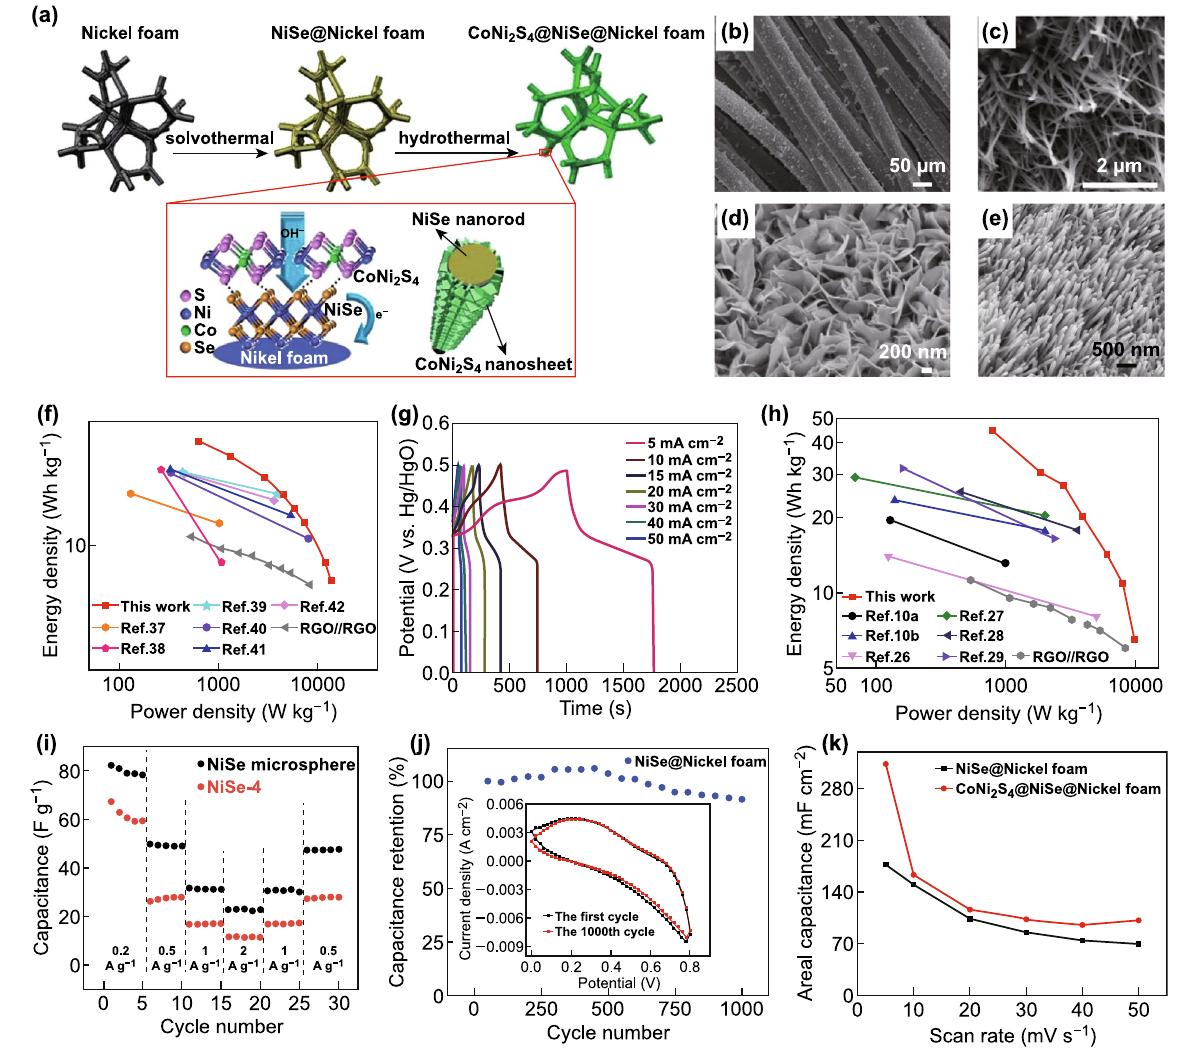
Fig. 10 a Schematic representation of in situ growth of CoNi 2 S 4 @NiSe nanoarrays on compressed foamed nickel. b FE-SEM image of NiSe 2 / CFC. c SEM image of (Ni, Cu) Se 2 -0.30. d FE-SEM image of NiSe@MoSe 2 nanosheet arrays. e SEM image of NiSe-0.20. f Ragone plot of SCs. g GCD curves for different doses of NISE-0.20 at different current densities. h Ragone plot of SCs. i Electrochemical performance of ASCs based on NiSe microspheres and NiSe microsphere discharge specific capacitance curves. j Flexible SC based on NiSe@nickel foam has a cycle performance of 1000 cycles at a scan rate of 50 mV s −1 . k Areal capacitance dependence on scan rates of flexible SCs based on the NiSe@nickel and CoNi 2 S 4 @NiSe@nickel foam. Adapted from Refs. [80–84] with permission. Copyrights 2016 (2017), The Royal Society of Chemistry; 2017, Elsevier; and 2017,